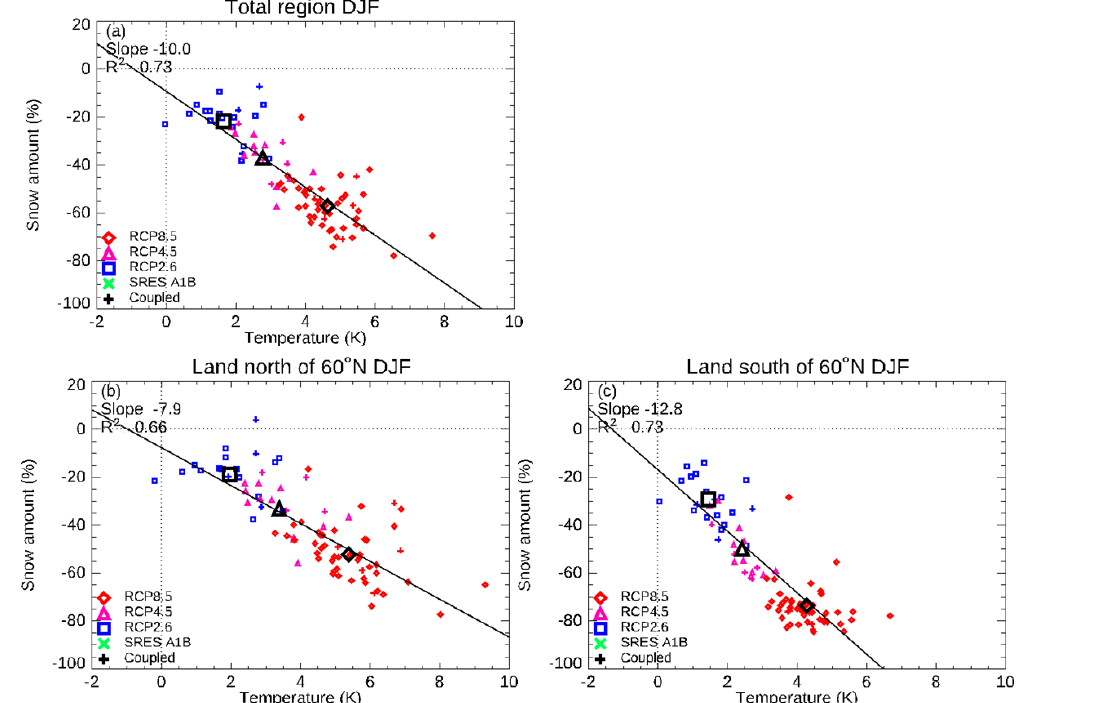
Figure 8. Relative change 1981–2010 to 2071–2100 of average winter (DJF) snow amount (kg/m 2 ) against temperature change for 84 individual model simulations from all scenarios. Scenario means are indicated by larger symbols. Squares: RCP2.6; triangles: RCP4.5; diamonds: RCP8.5. Purple colour: the RCA4-NEMO atmosphere–ocean coupled simulations. Calculation performed for subsets of land points in the Baltic catchment: the entire catchment; land points north and south of 60 ◦ N, respectively. The lines, with quoted slope and squared correlation coefficient, are best fits to all EURO-CORDEX data but do not include coupled-model